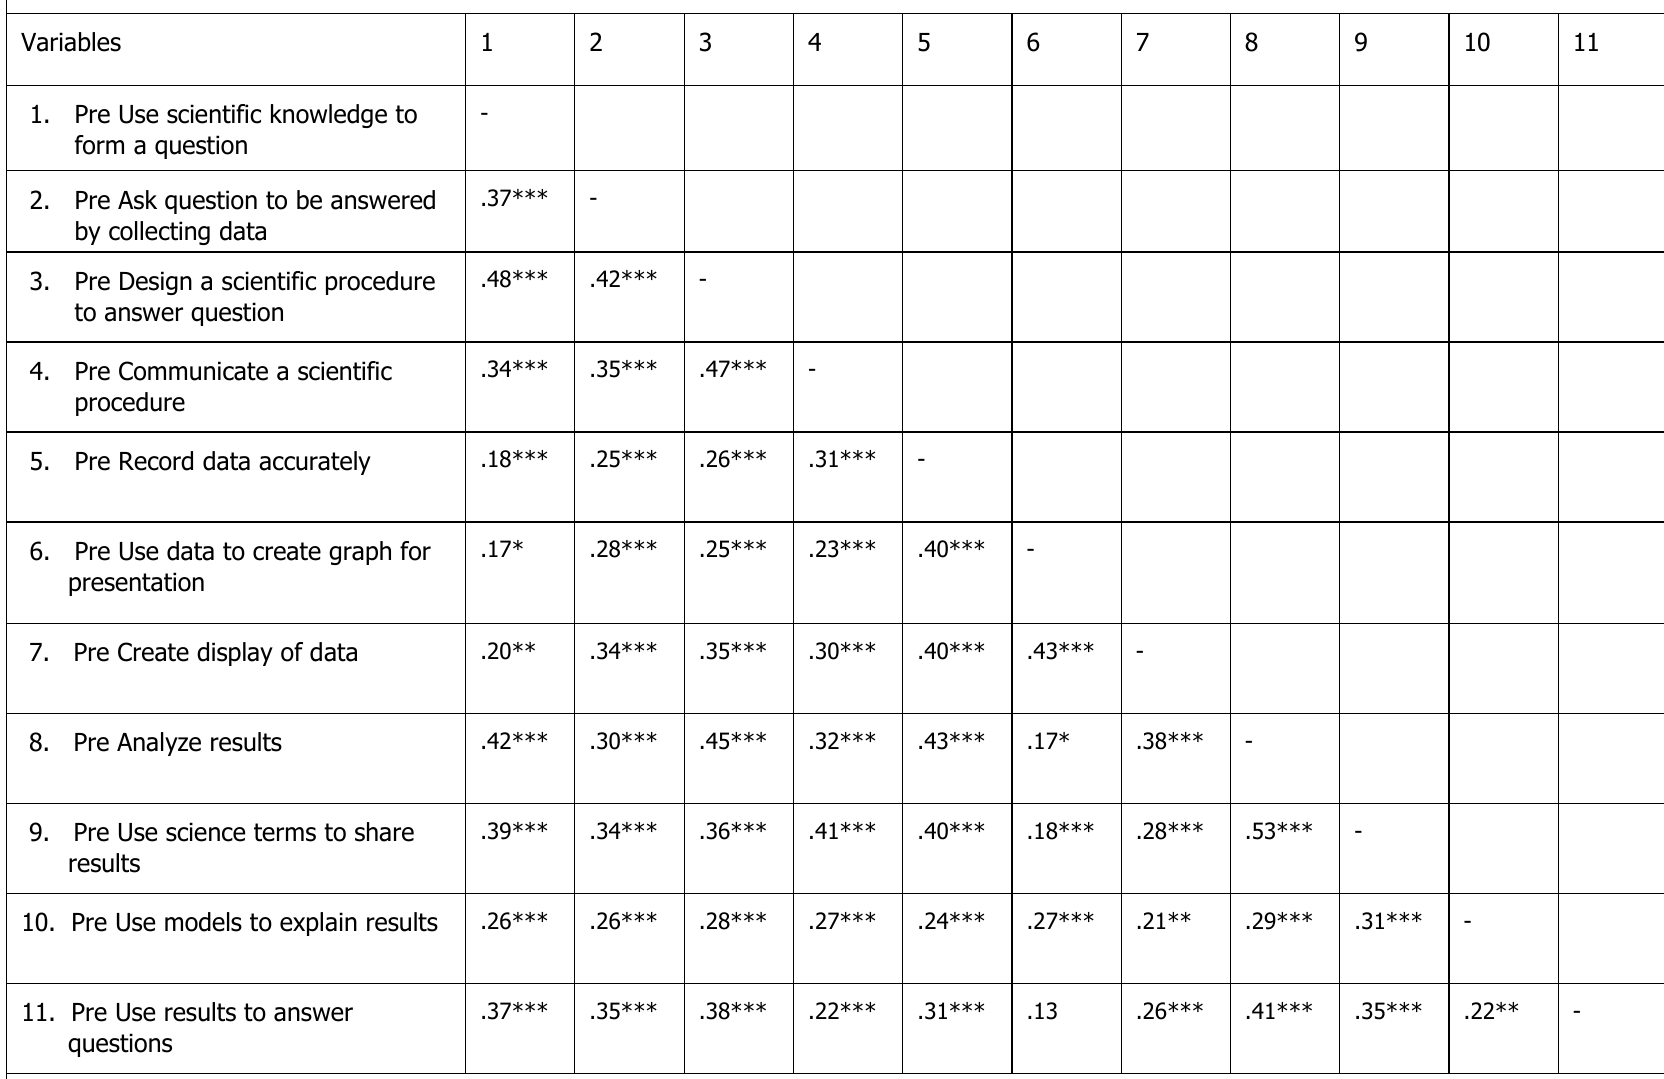
Correlations between Pre-test SPSI